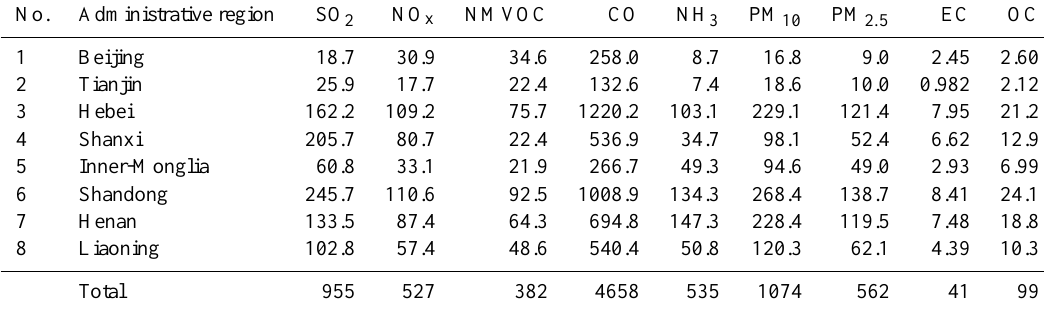
Table 13. Anthropogenic emissions by province in the larger Huabei region in 2003 (units: 10 4 tonyr − 1 ). No. Administrative region SO 2 NO x NMVOC CO NH